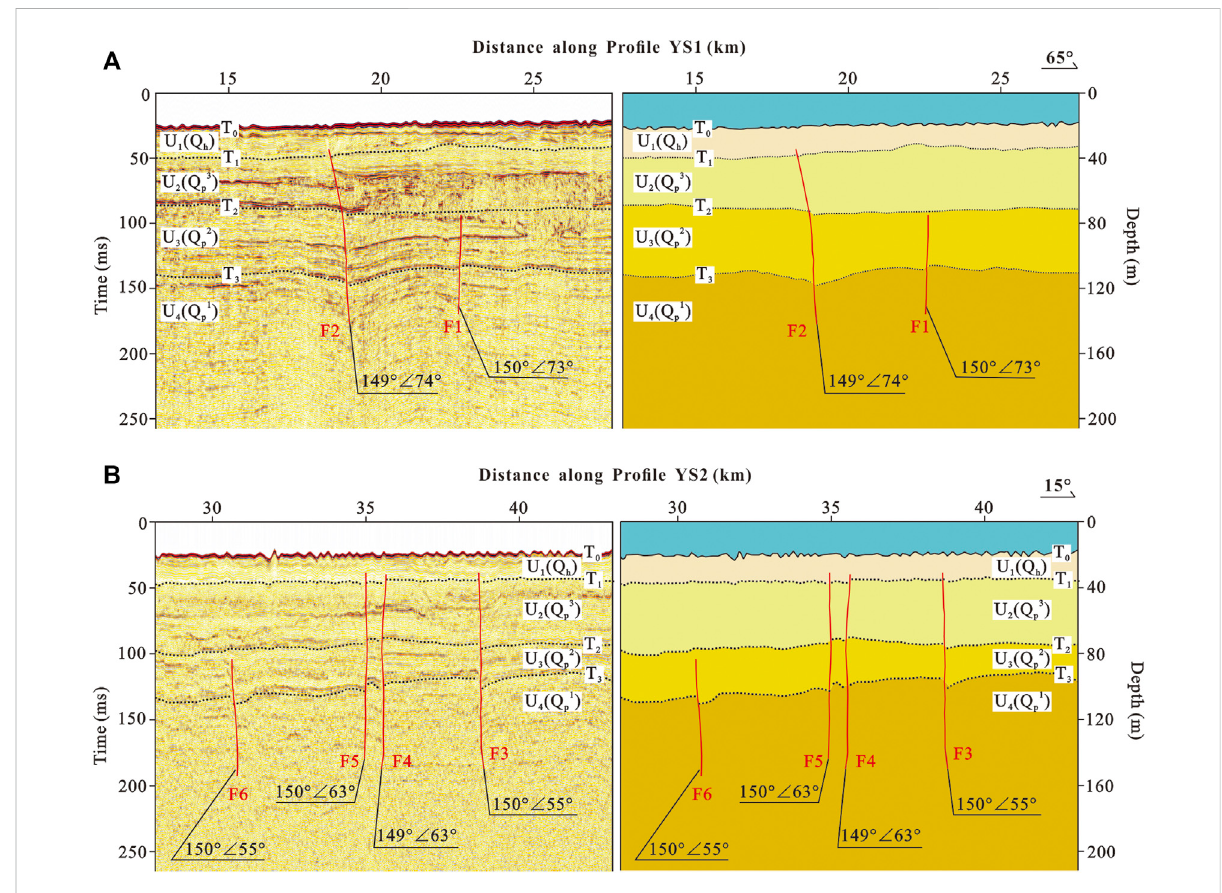
FIGURE 4 Characteristics of the interpreted faults revealed by pro fi les. (A) YS1 pro fi le; (B) YS2 pro fi